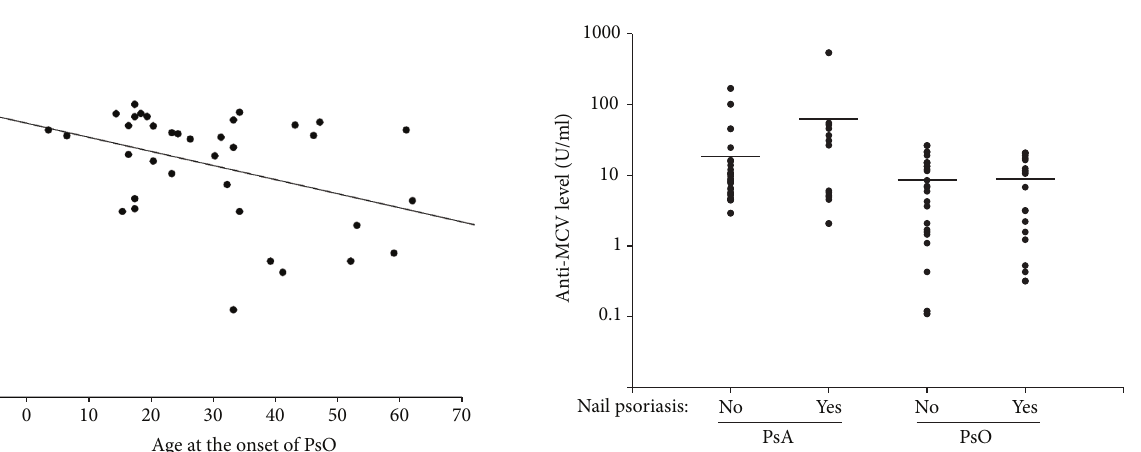
Figure 3: Anti-MCV titers are higher in severe PsO patients treated with biological therapy than in moderate-to-severe psoriasis patients not requiring biological therapy. The plots show the anti- body levels of investigated patients. The horizontal lines indicate the mean levels of anti-MCVs. ∗ The PsO patients not requiring biological therapy had significantly lower anti-MCV levels than those treated with biological therapy ( 3.01 ± 3.34 U/mL versus 14.01 ± 6.22 U/mL; 𝑃 < 0.01 ).